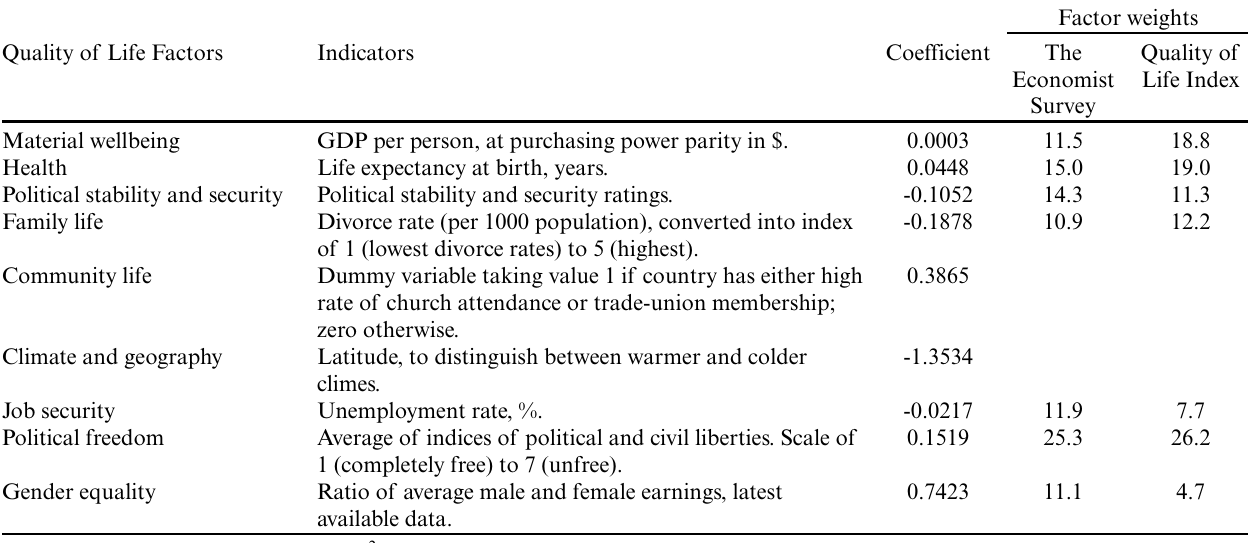
Table 1 . Nine factors of The Economist Intelligence Unit's Quality of Life Index (2004) and factor weights applied to mapping quality of life in the Albemarle-Pamlico